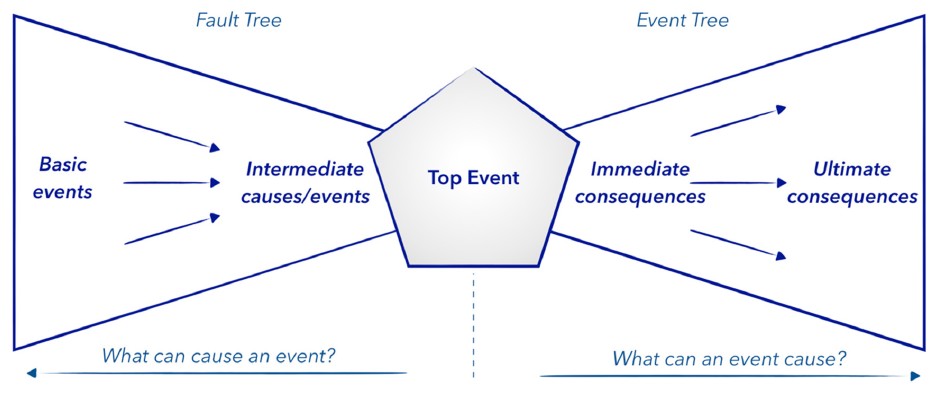
Figure 2. Scheme of a Bow-Tie Structure—Redrawn from [20].